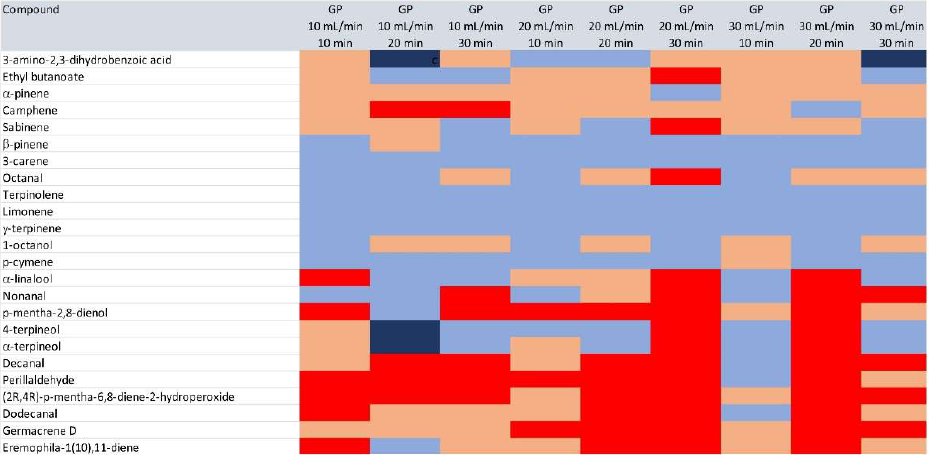
Figure 2. Heat map showing the changes in the mass fraction of volatile components with the untreated juice as a basis for comparison. Blue and red colors indicate an increase and decrease in concentration, respectively. Light colors indicate changes between 0 and 50% in the component’s mass fraction. Darker colors indicate changes above 50% in the component’s mass fraction.